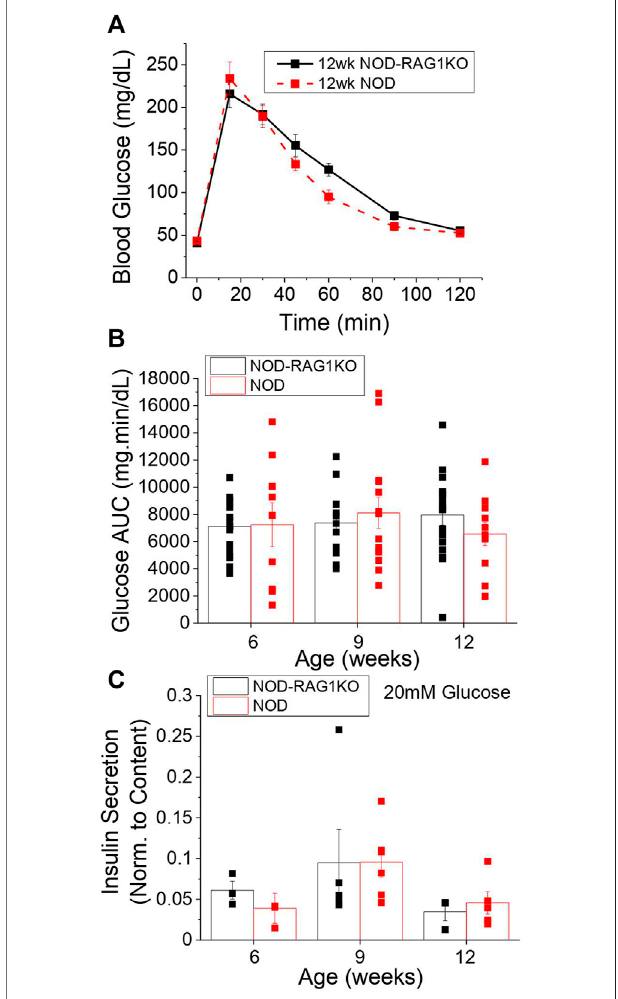
FIGURE1| NODmicearenormoglycemicat12 weeksofage. (A) Blood glucose levels in 12-week old NOD ( n = 7 – 13) and NOD-RAG1KO ( n = 8 – 15) mice following a glucose tolerance test starting at time 0. (B) Glucose area under thecurve for6, 9, and 12 week oldNOD (red) and NOD-RAG1KO (black)mice calculatedfrom blood glucose levels measured over 2 hfollowing glucosechallenge in as A. (C) Insulin secretion normalized to insulin content in isolated islets from 6, 9, and 12 week old NOD ( n = 4 – 6) and NOD-RAG1KO ( n = 3 – 5) mice at 20 mM glucose. Data in all panels represents the mean ± SEM. In B and C, data from individual mice are represented by black and red squaresforNOD-RAG1KO andNODmice respectively.All animals arefemale unless otherwise